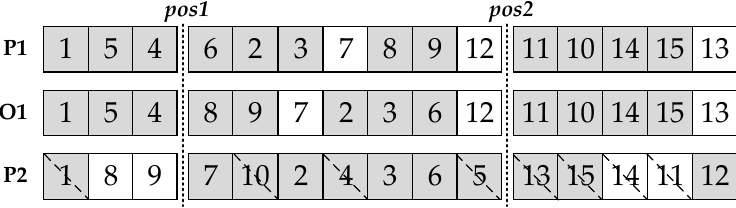
Figure 7. An example of crossover for operation layer.